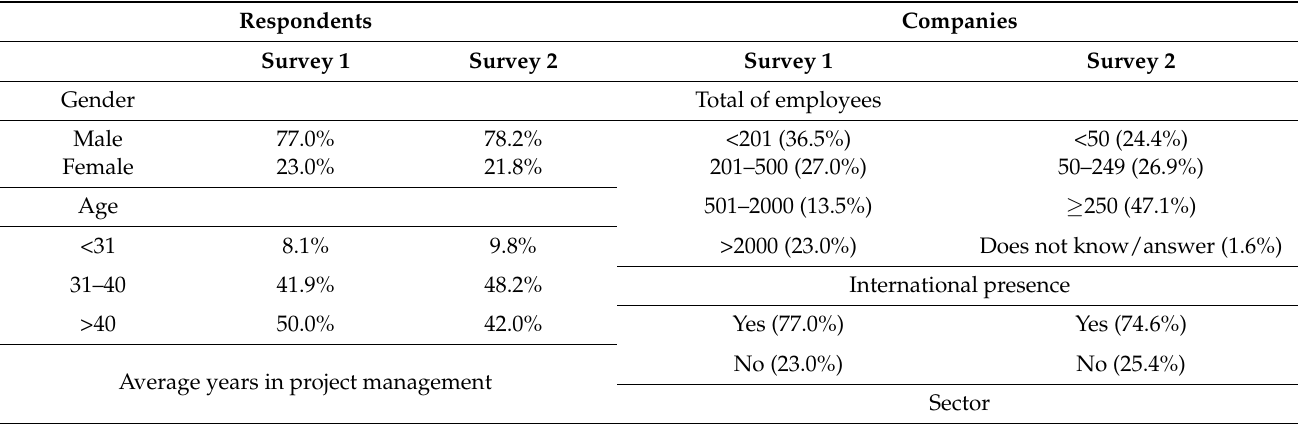
Table 1. Profiles of respondents and companies.